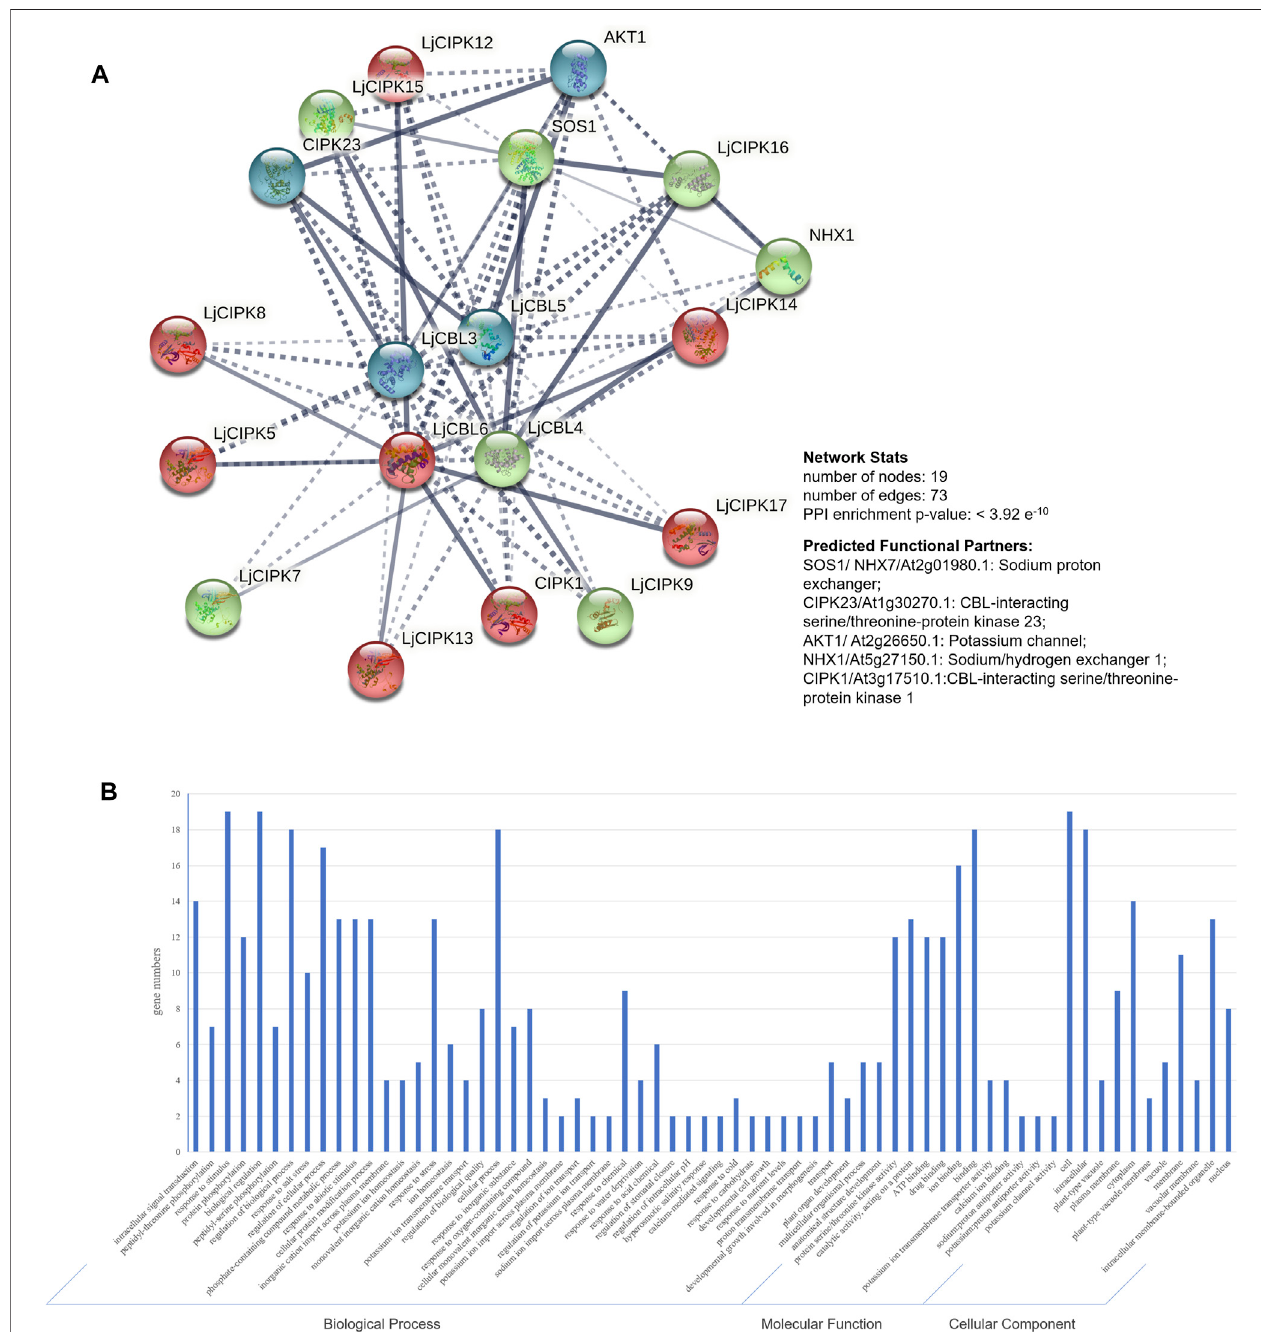
FIGURE5| Protein-proteininteraction(PPI)predictionofLjCBLsandLjCIPKs (A) PPInetwork.Linethicknessindicatesthestrengthofdatasupport.Thenetworkis clustered into 3 clusters, which are represented with red, green, and blue nodes, respectively (B) Gene Ontology (GO) analysis of the genes from the PPI network.